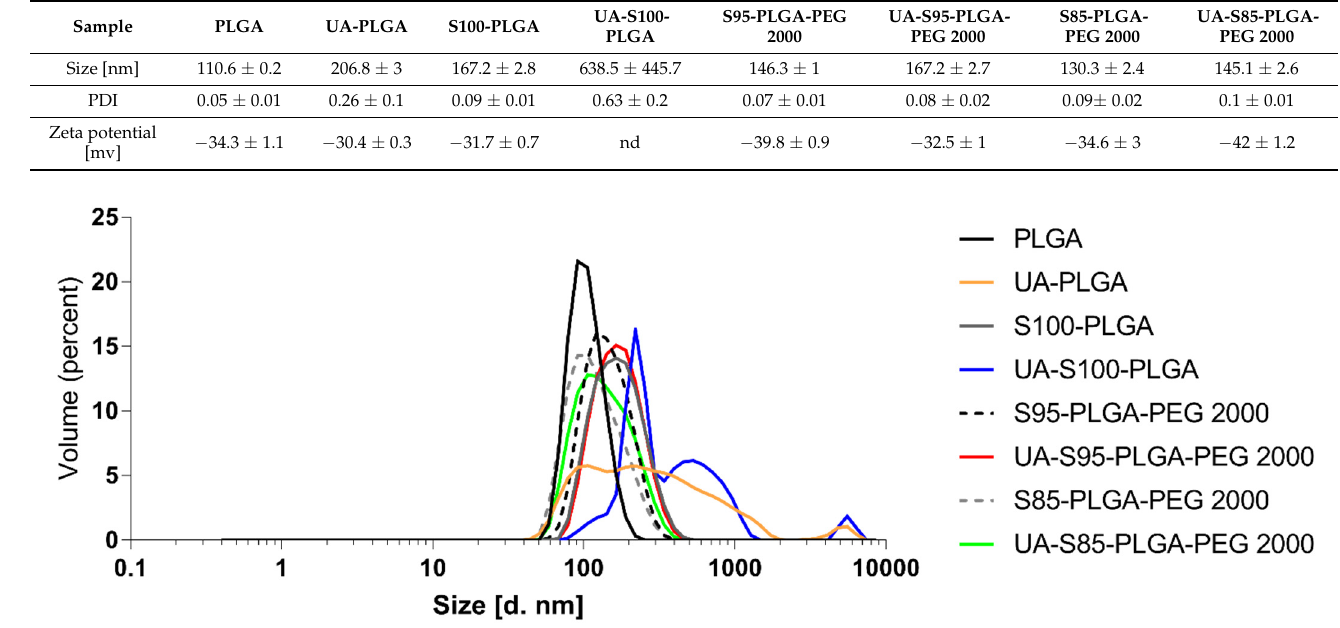
Table 2. Nanoparticles’ characterization: size, PDI, and zeta potential values; nd—not determined.